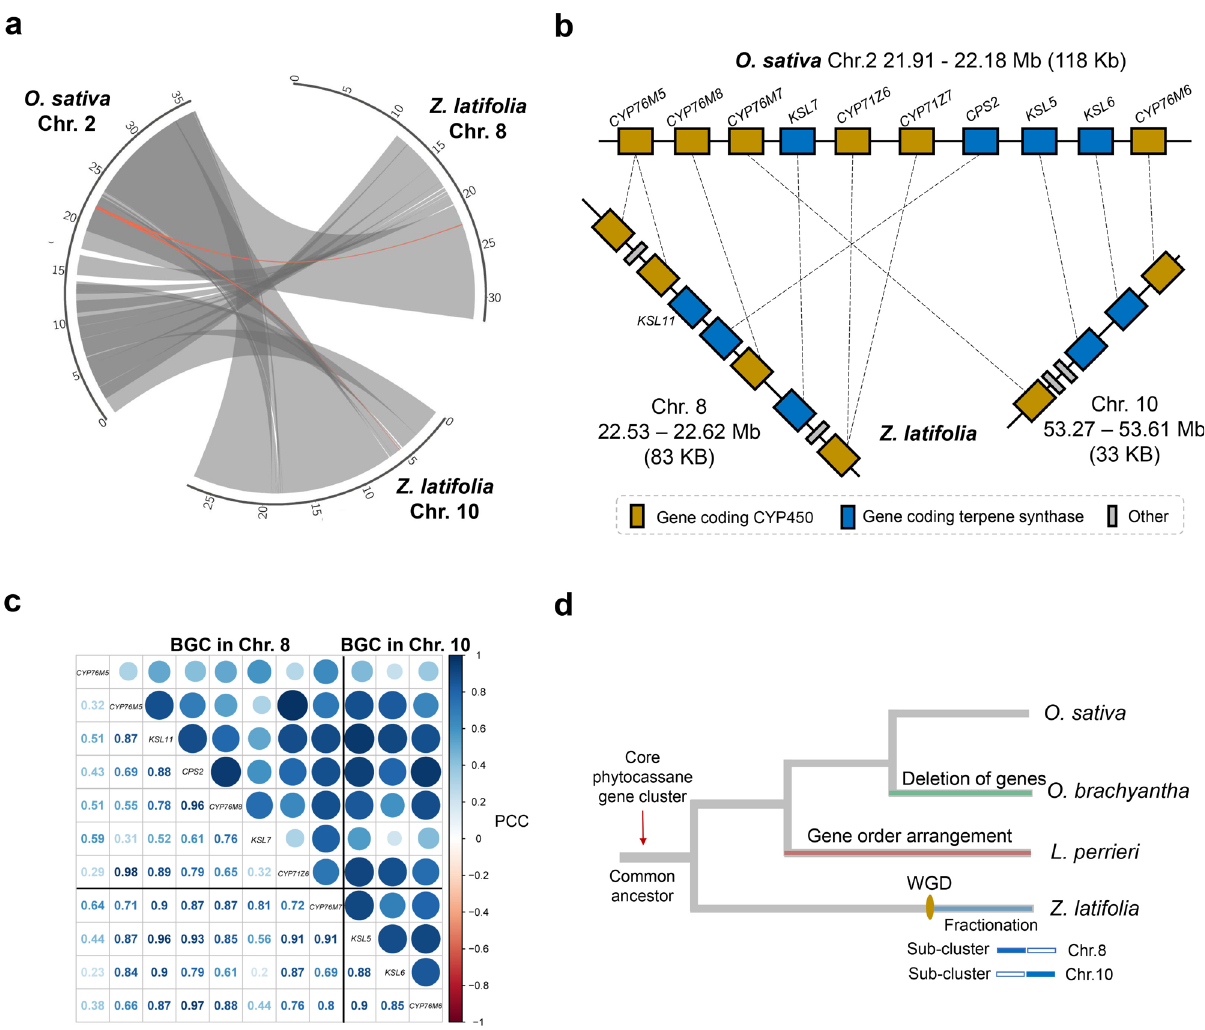
Fig. 5 Characterization of the phytocassane biosynthetic gene cluster in Zizania latifolia genome. a , Genomic synteny between chromosome 2 of O. sativa and chromosomes 8 and 10 of Z. latifolia . Syntenic genomic blocks are illustrated by the grey lines. The homologous genomic regions of phytocassane biosynthetic gene clusters between O. sativa and Z. latifolia are highlighted in red. b Gene-level synteny between phytocassane biosynthetic gene cluster of O. sativa and Z. latifolia ; CYP450 genes are colored dark yellow; genes coding terpene synthases are colored dark blue. The genes unrelated to the cluster are in grey. c Gene co-expression pattern for the genes in the two sub-gene clusters in chromosomes 8 and 10. d , Proposed evolutionary history of the phytocassane biosynthetic gene cluster in the Z. latifolia , L. perrieri , and Oryza were used for further analysis. Before chromosome assembly, we performed a preassembly for error correction of scaffolds, which required the splitting of scaffolds into 50-kb segments. Hi-C data were then mapped to these segments using the Burrows – Wheeler Alignment software. The uniquely mapped data were retained to perform assembly using LACHESIS 50 .